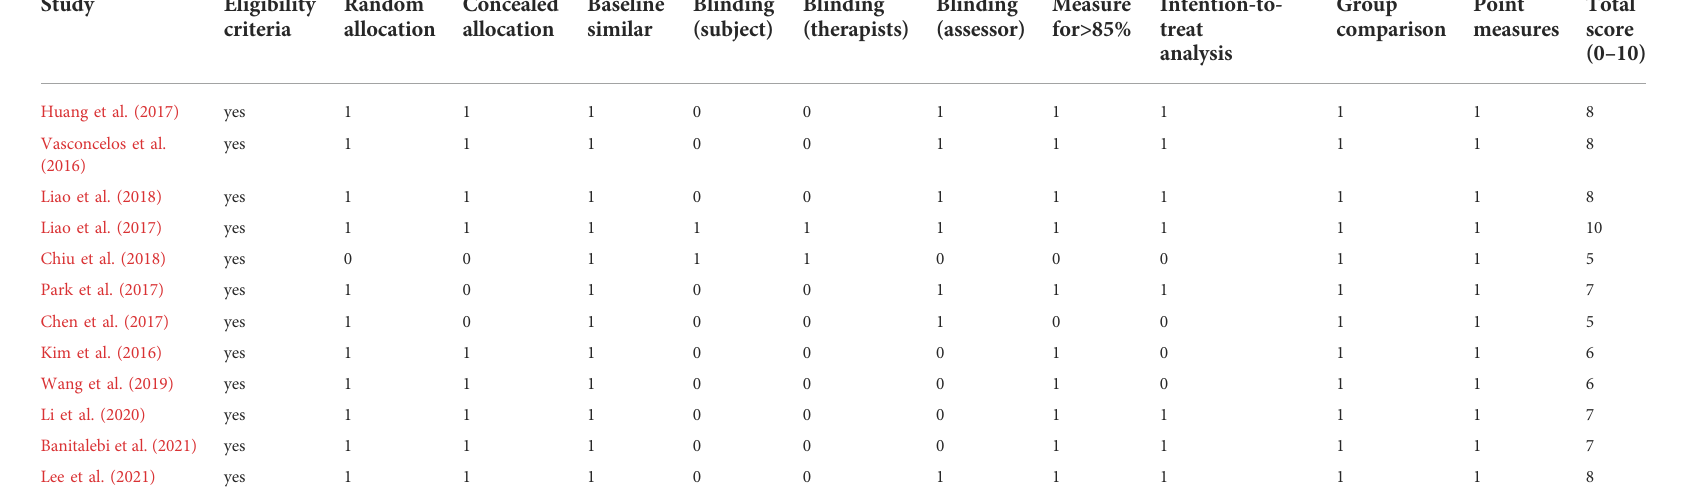
TABLE 4 PEDro criteria and scores of included